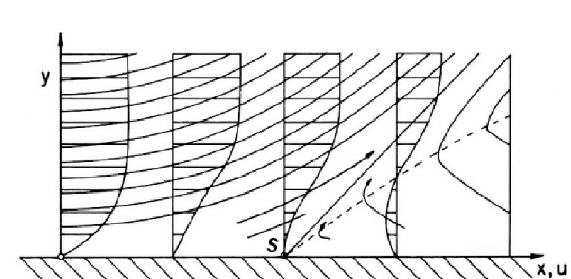
Figure 1. Prandtl’s sketch of the streamlines and velocity profiles in the vicinity of the separation point S . To the right of the separation point, a reverse flow is